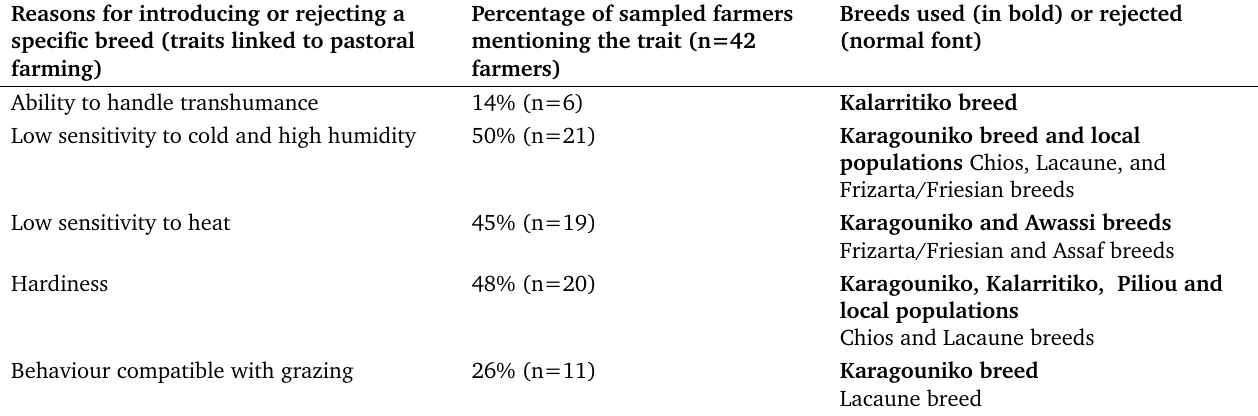
Table 4. Breeds’ traits motivating the introduction or rejection of a specific breed in the flock: the case of traits linked to pastoral farming. Hardiness (or a similar term) was used by farmers to characterize the overall ability of the breed to withstand the constraints of its raising